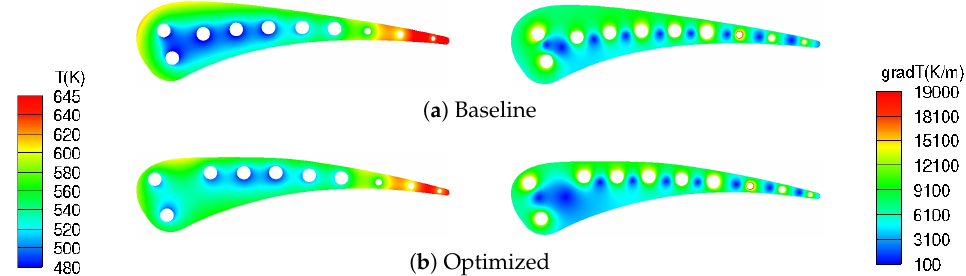
Figure 9. Computed temperature ( left ) and temperature gradient magnitude ( right ) fields for the baseline and the optimized configurations.